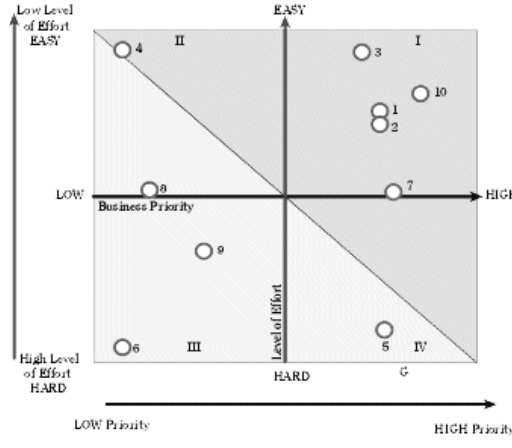
Figure 1. A sample BI opportunity scorecard